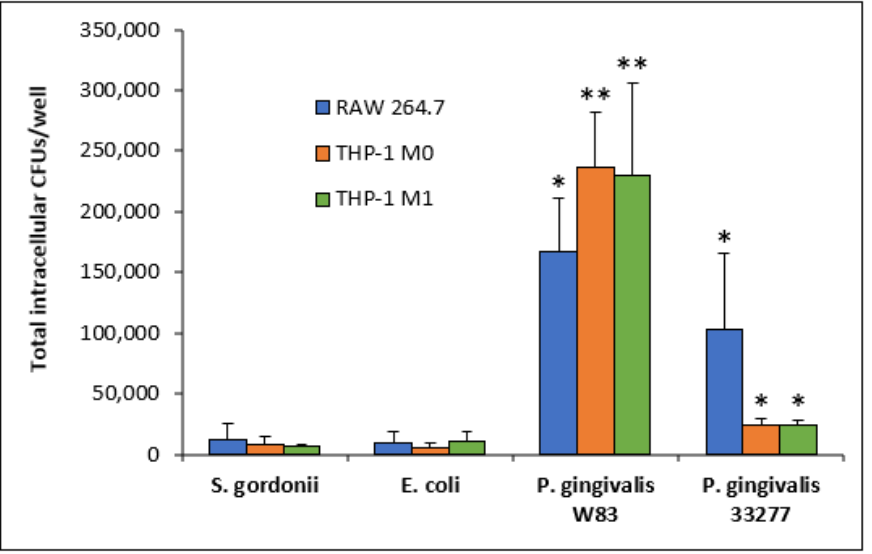
Figure 4. Amounts of intracellular S. gordonii, E. coli, P. gingivalis W83, and P. gingivalis 33277 CFUs in RAW 264.7 (blue), THP-1 M0 (red), and THP-1 M1 (green) cell cultures. Each value is the average and SD from at least n = 6. *, statistically significant compared to S. gordonii and E. coli ( p < 0.05). **, statistically significant compared to S. gordonii , E. coli and P. gingivalis 33277 ( p < 0.05). Table 2. Entry, escape, and re-entry of bacteria in and out of THP-1-derived M1 cells.